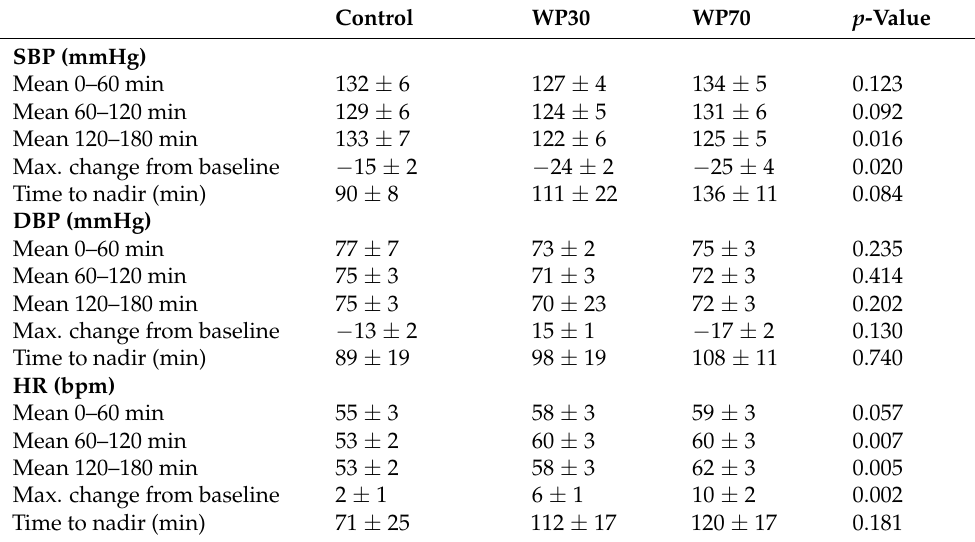
Table 1. Blood pressure and heart rate after whey protein drink